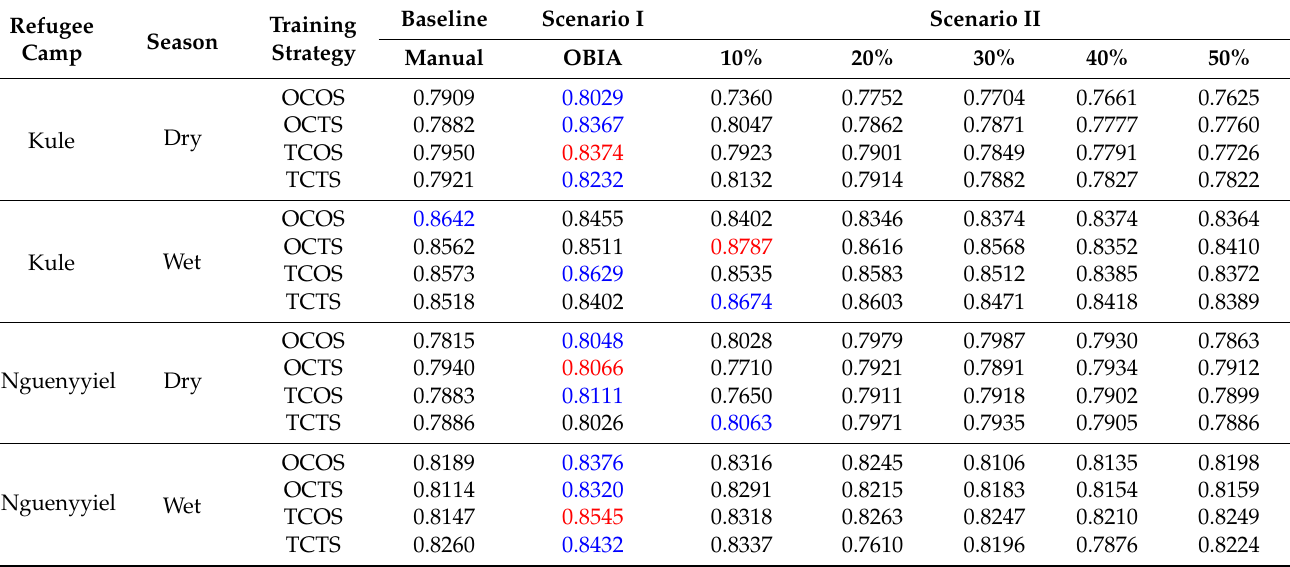
Table 4. The Precision values of built-up structures of all implemented